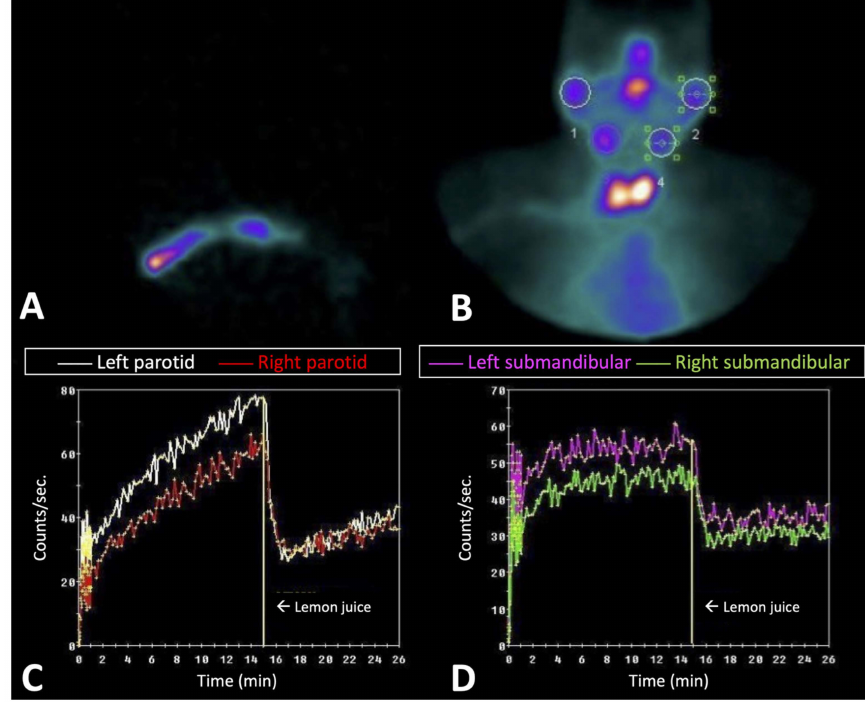
Figure 2. Dynamic study with 99m TcO 4 − in patients with Sjögren syndrome 3 years after diagnosis. ( A , B ) show the start of dynamic images and the summary of all dynamic images,